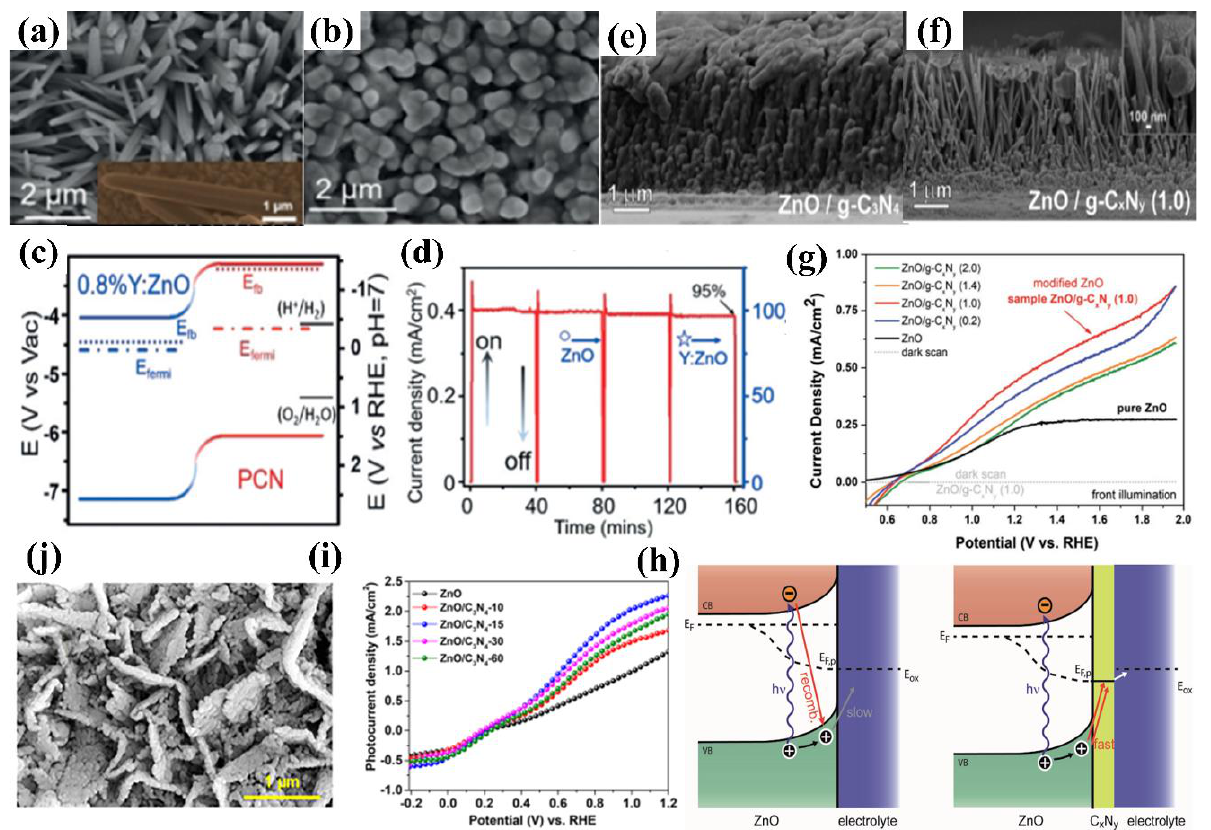
Figure 19. Top − view SEM images of ( a ) 0.80%Y:ZnO NRs, ( b ) 0.8%Y:ZnO/g − CN core-shell photoanode (the inset is the single 0.8%Y:ZnO NR). ( c ) Schematic illustration of the energy band alignment and water redox potentials. ( d ) The stability test of the core-shell photoanode at 1.23 V vs. RHE. Reprinted with permission from ref. [188] Copyright 2018 John Wiley and Sons Ltd. ( e , f ) Cross − section FEG − SEM images of ( e ) ZnO nanowires (NWs) coated with cyanuric acid − melamine (CM) complex as the source of g − CN followed by using powder deposition technique, and ( f ) ZnO-NWs treated with CM complex followed by using dip − coating deposition. ( g ) LSV measurements of the samples fabricated via dip − coating different concentrations of CM dispersion. ( h ) Schematic of the proposed working mechanism. Reprinted with permission from ref. [190] Copyright 2017 John Wiley and Sons Ltd. ( i ) LSV curves. ( j ) FESEM images of ZnO/g − CN QDs. Reprinted with permission from ref. [191] Copyright 2020 American Chemical Society.